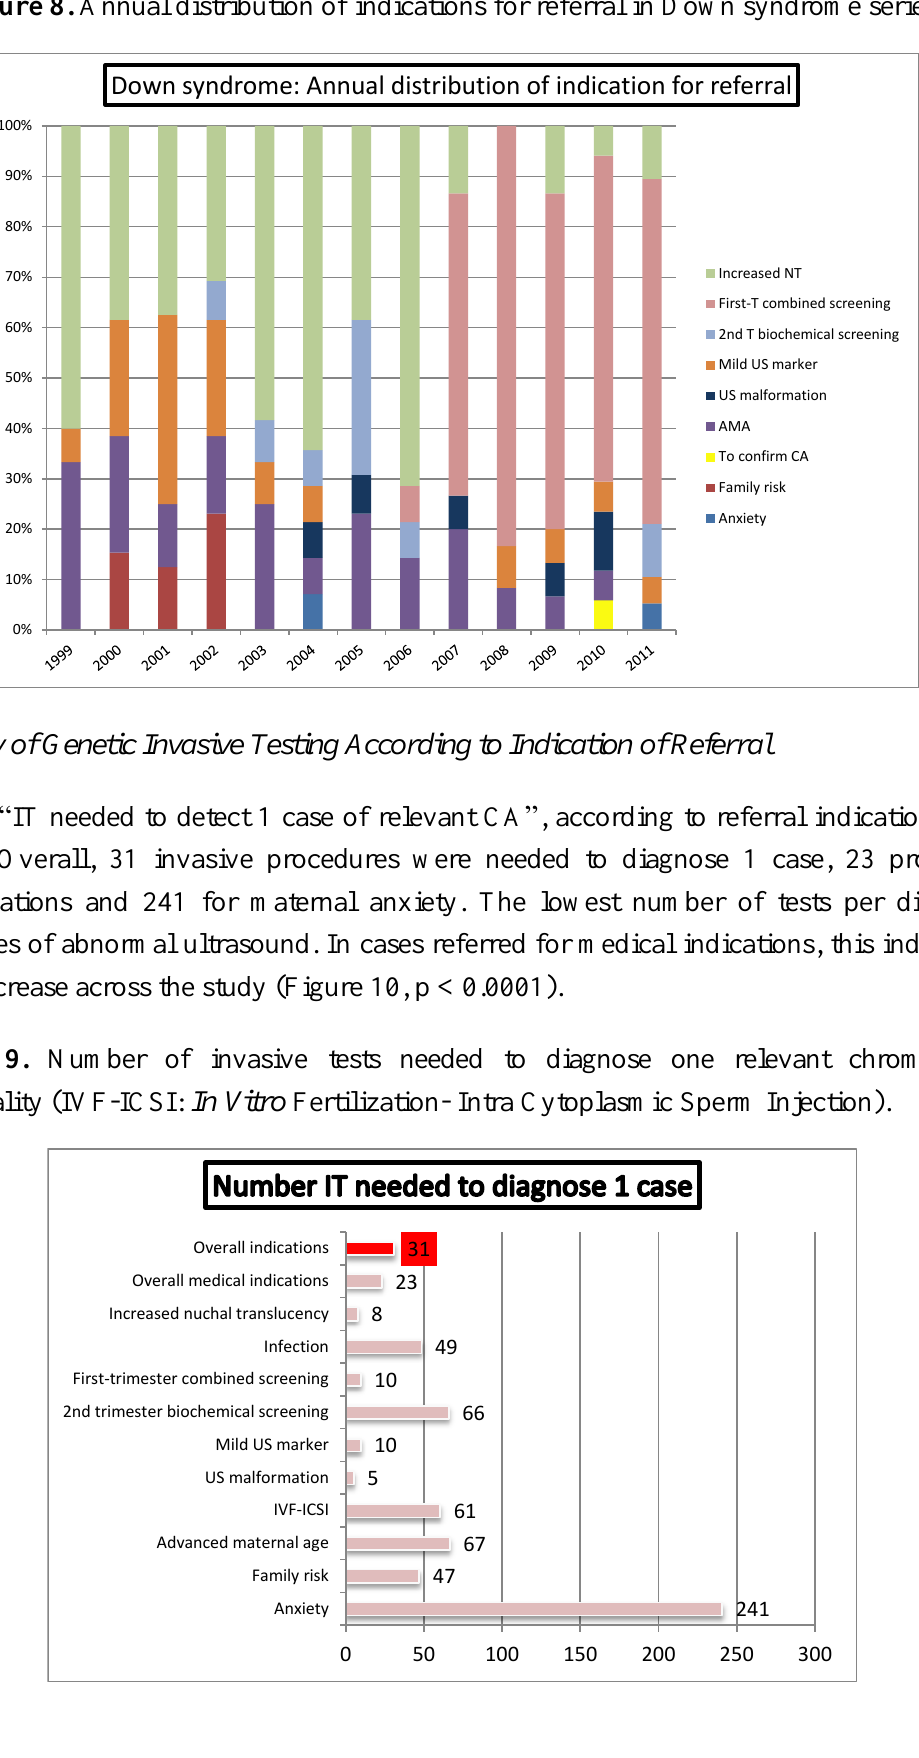
Figure 8. Annual distribution of indications for referral in Down syndrome series.